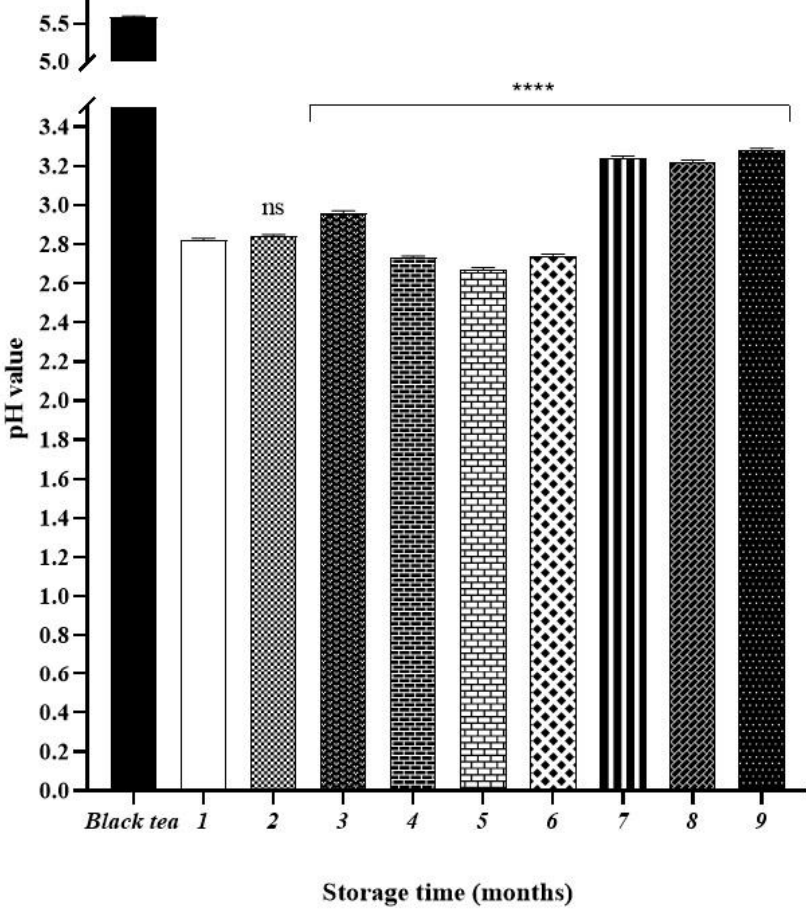
Figure 1. Values of pH determinate in black tea, kombucha tea after 30 days of fermentation and all the samples during storage. Black bar refers to the starting tea. White bar refers to the kombucha sample after 30 days of fermentation (control). Values represent the three-measure mean ± standard deviation. Asterisks on the bars indicate that mean values were statistically different from the control (**** p < 0.0001).